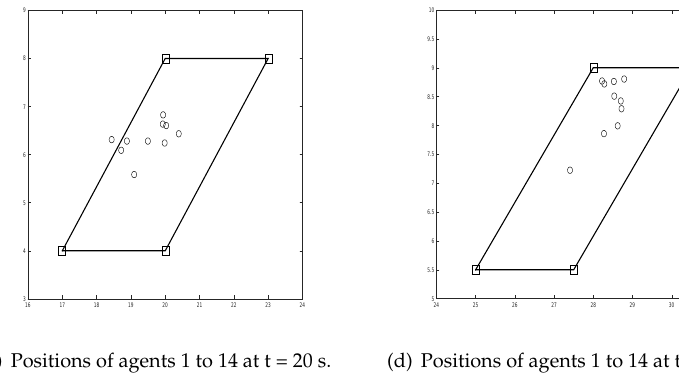
(a) Positions of agents 1 to 14 at t = 0 s. (b) Positions of agents 1 to 14 at t = 10 s.